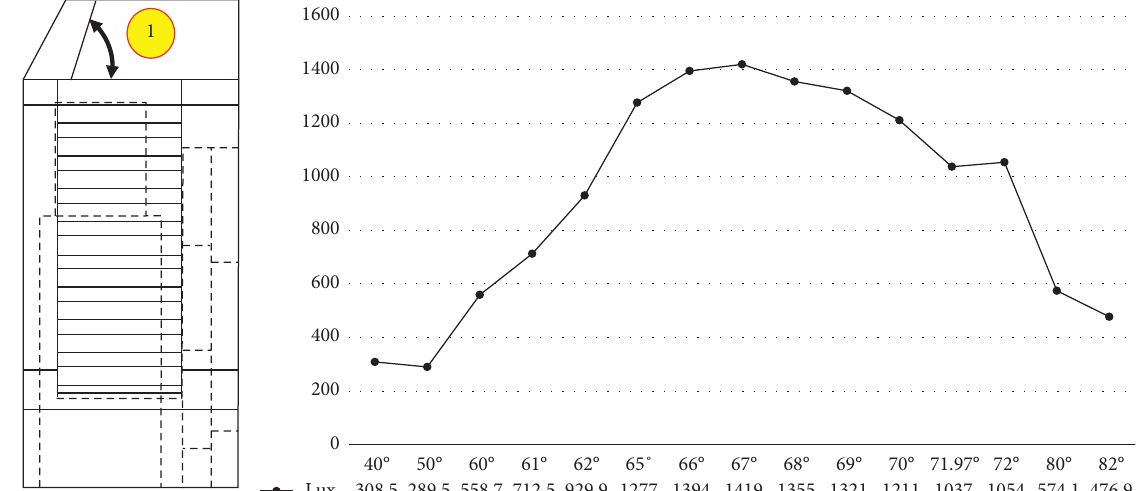
Figure 8: Schematic diagram of geometric bevel angle 1 and optical simulation results.